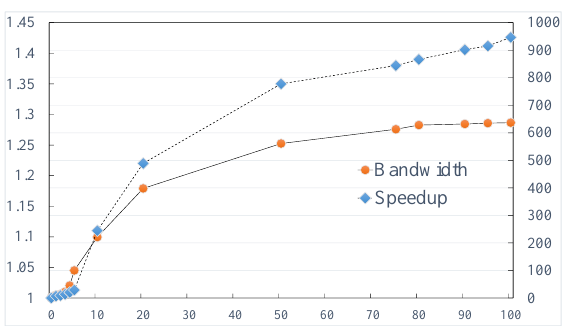
Figure 3. Bandwidth of a Flush+Reload based side-channel and performance improvement by allowing a specific ratio of cache operations passing through ARM